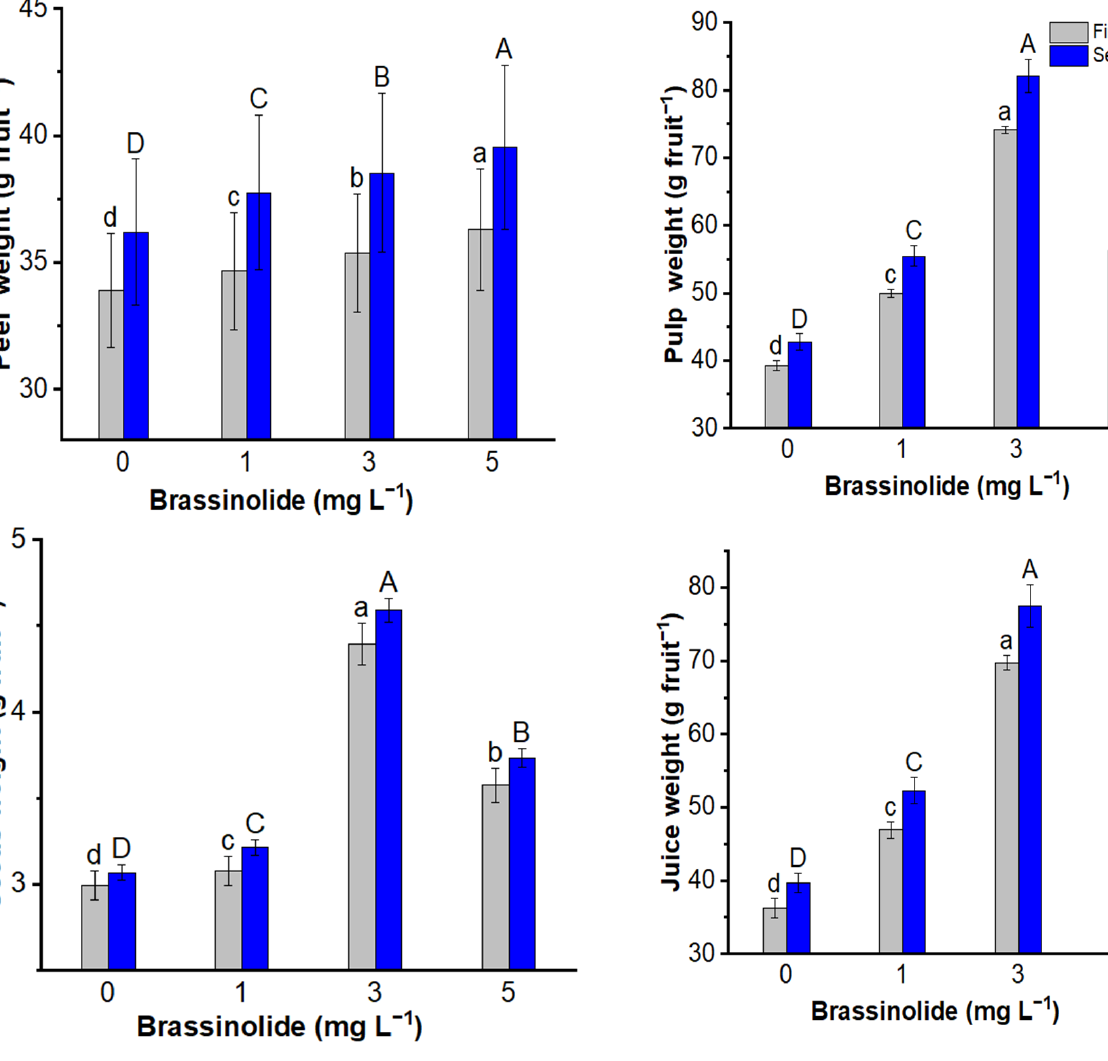
Figure 2. Peel weight fruit − 1 (g), pulp weight fruit − 1 (g), seeds weight fruit − 1 (g), and juice weight fruit − 1 (g) of Opuntia ficus-indica L. plant subjected to brassinolide foliar spray. Data are mean value ± SE. Bars with the same letters (lowercase for the first season and uppercase for the second season) are not significant at p ≤ 0.05 level.